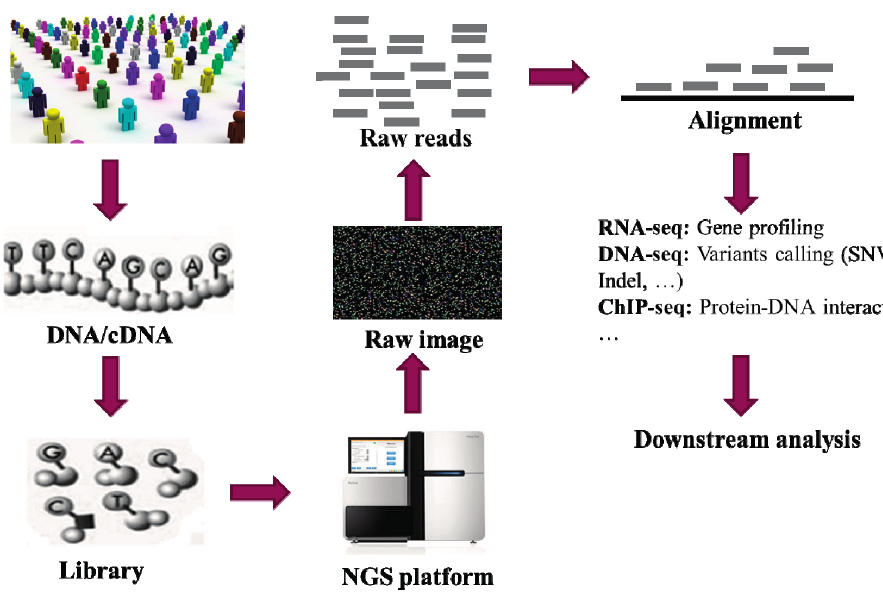
Figure 1. A brief flow chart of genetic studies using NGS. In the first step, DNA or cDNA samples are extracted from the cells of individuals. Then each of the samples is cleaved into small fragments and PCR is carried out to build the library by amplifying each of the small fragments. The library is then sequenced using the NGS platform. The original output from the NGS platform is a set of images. Thereafter, a base-calling algorithm